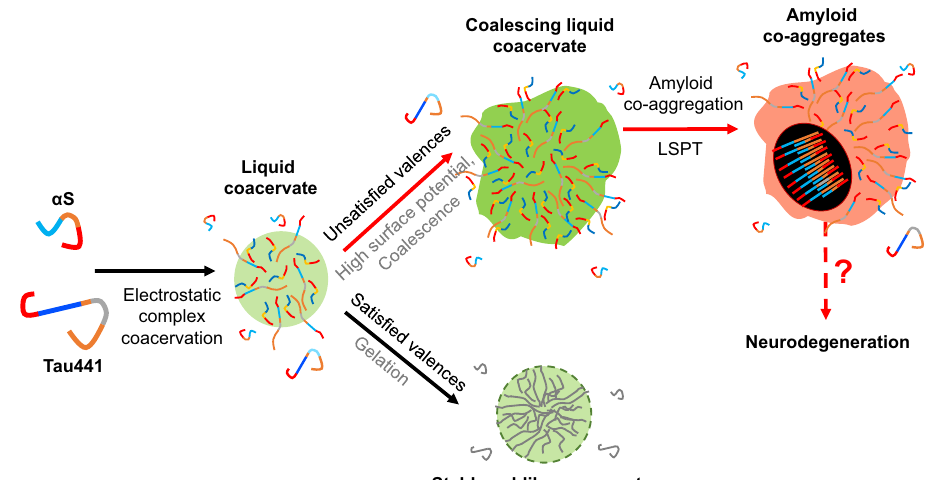
Fig. 8 | Model for the synchronized LLPS and LSPT-driven amyloid hetero- aggregation of α S and Tau441. The schematic shows the proposed amyloid aggregation pathway for α S and Tau441 through LLPS and LSPT. With